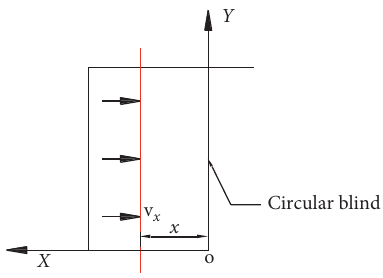
Figure 3: Calculation of the geotextile